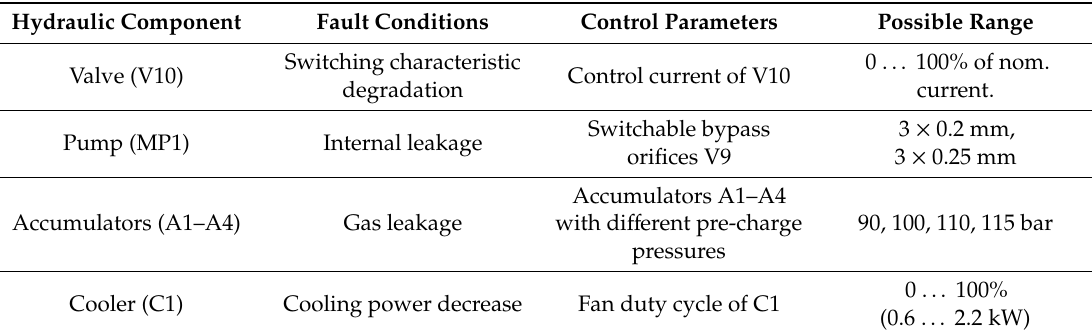
Table 2. Hydraulic test bed: components and their simulated fault conditions.